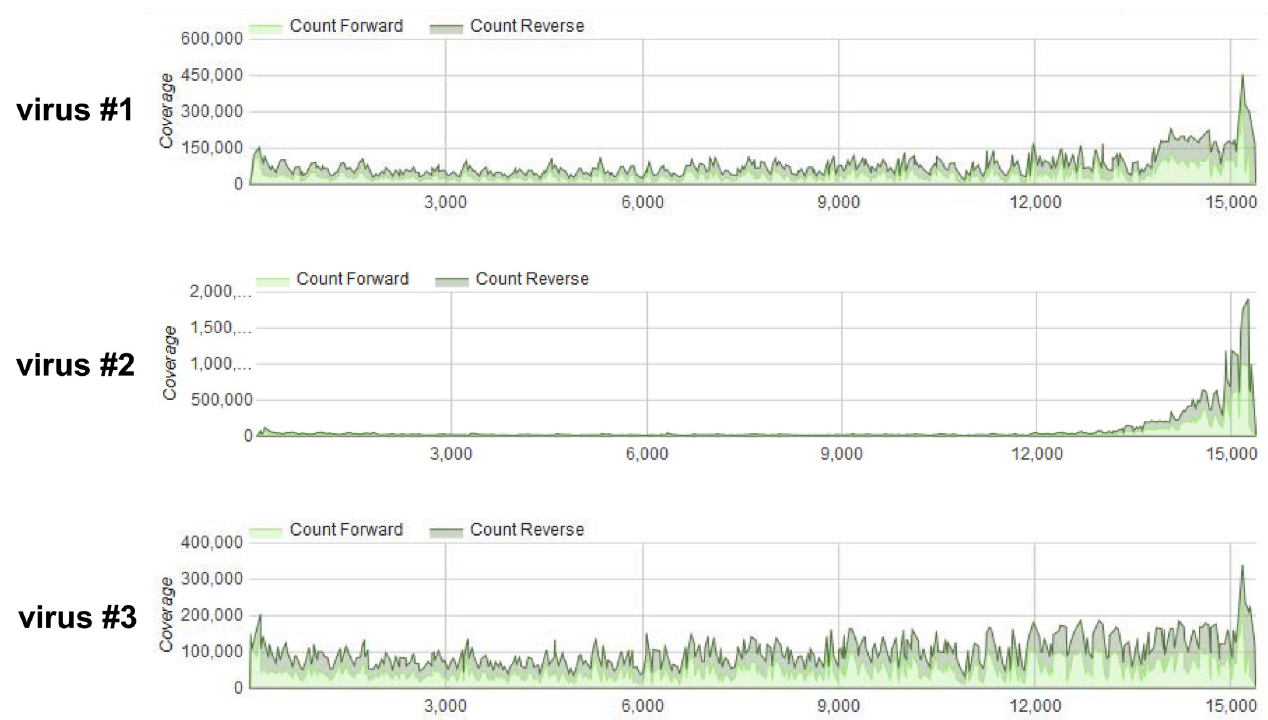
Fig 7. Differences in depth of coverage obtained by HTS from three recombinant MuV rescued from the same cDNA. Crude virus-containing cell culture supernatants were treated with Micrococcus nuclease followed by viral RNA extraction and high throughput sequencing using a HiSeq instrument. Data were analyzed using CBERs specialized high-performance integrated virtual environment (HIVE) platform. Note the steep increase in depth of coverage at the 5’ end of virus #2 compared to viruses #1 and #3.